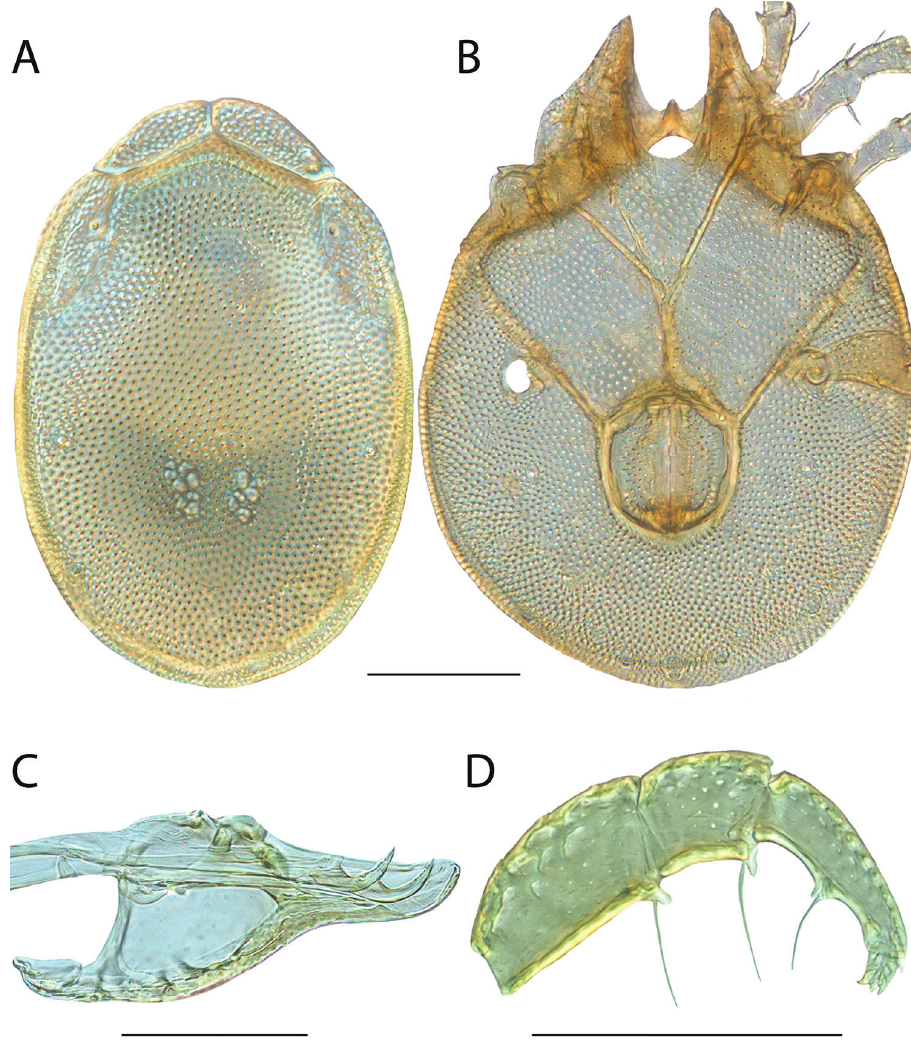
Figure 139. Torrenticola malarkeyorum sp. n. male: A dorsal plates B venter (legs removed) C subcapitulum D pedipalp (setae not accurately depicted). Scale = 100